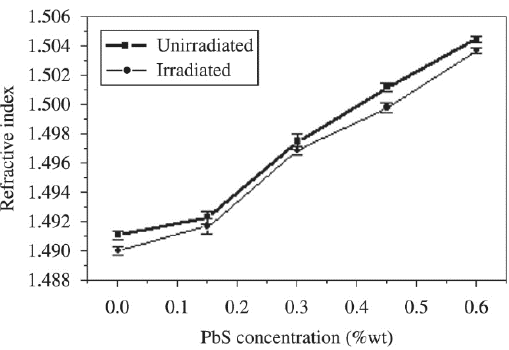
Figure 7. TGA curve of PMMA-control and PMMA/PbS-NP for a) unirradiated and b) irradiated